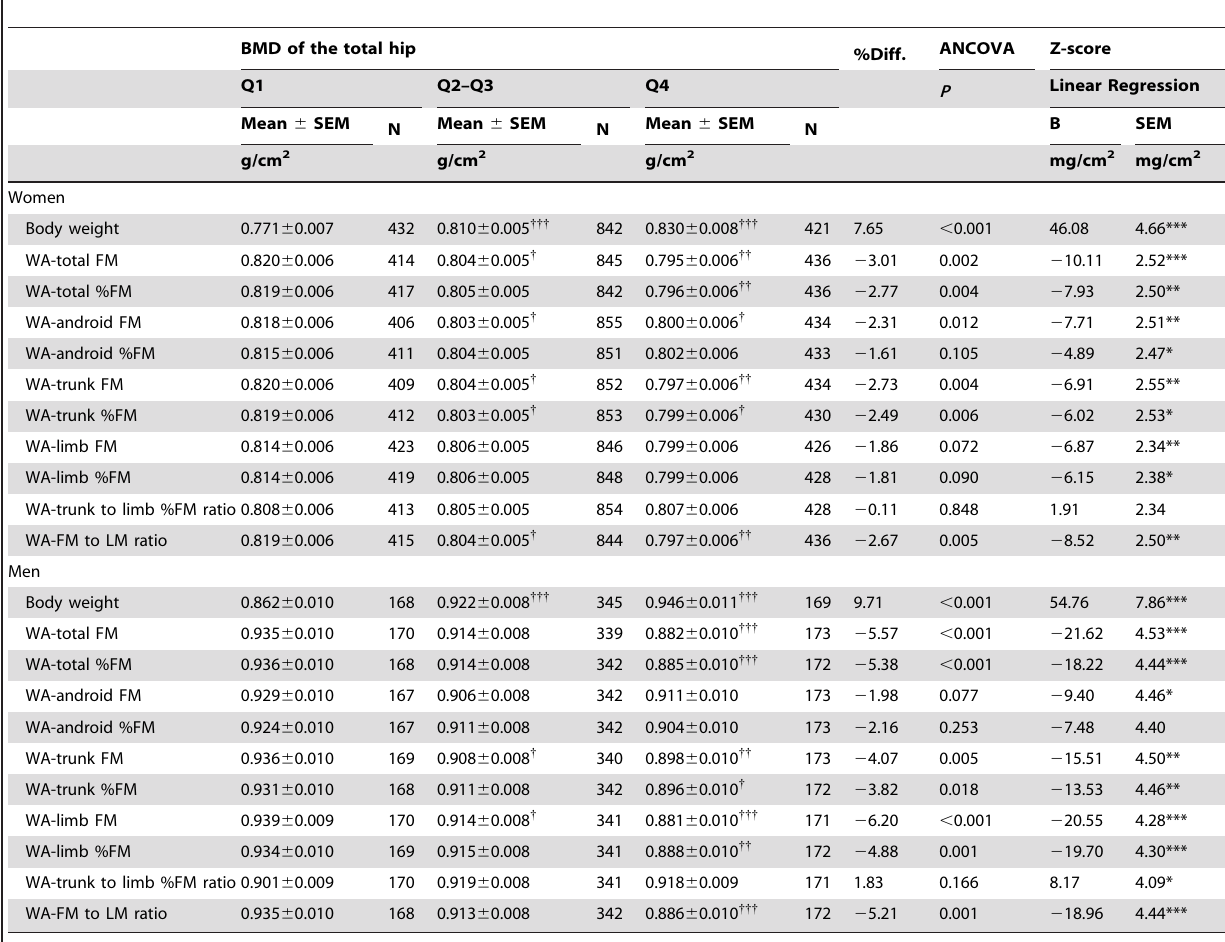
Table 3. Covariate-adjusted mean (SEM) bone mineral density of the total hip by quartiles of each WA-index of FM.